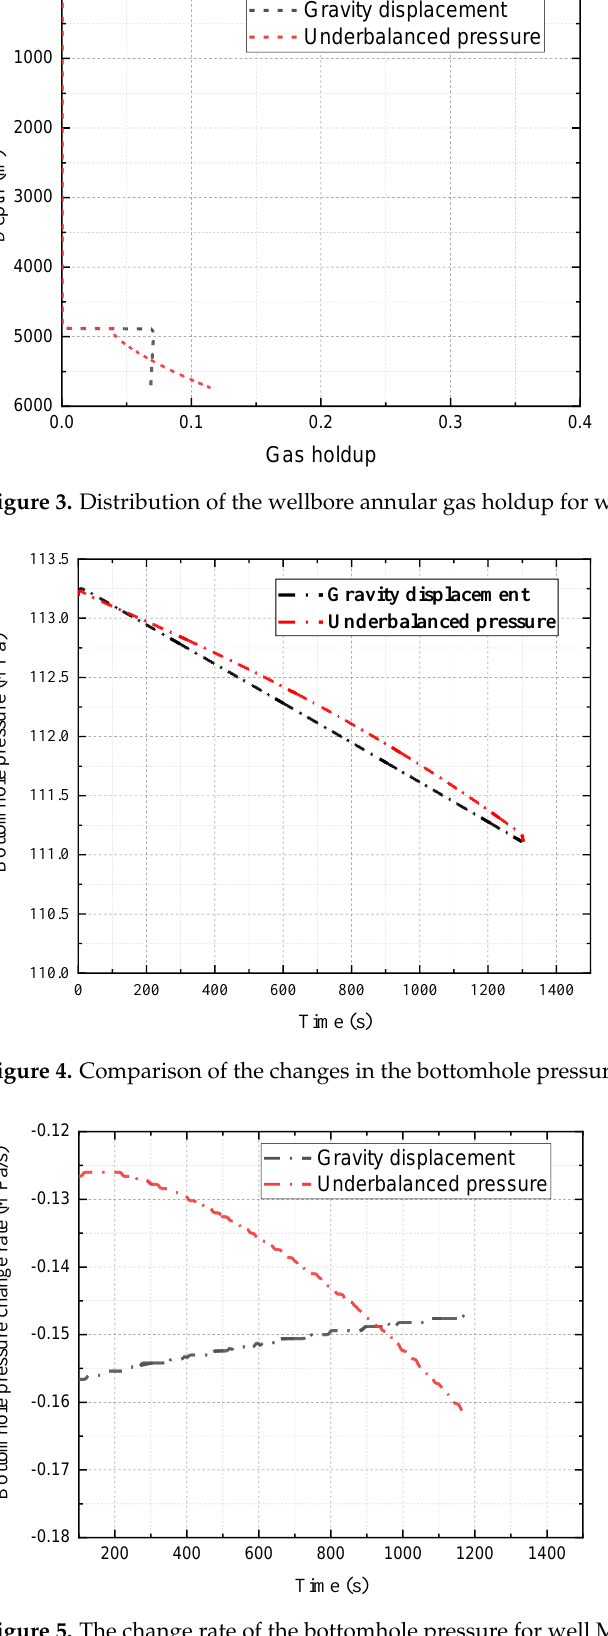
Figure 5. The change rate of the bottomhole pressure for well M. Figure 6 illustrates the variation of the pit gain with time, during the underbalanced pressure gas kick and the gravity displacement gas kick, and their overflow volumes both reach 2 m 3 at 1300 s. It can be seen that the pit gain under the gravity displacement gas kick is approximately a straight line with time, while it presents a curve with time, during the underbalanced pressure gas kick. The change rate of the pit gain with time is the in- crement of the wellhead outlet flow rate, as shown in Figure 7. The outlet flow rate under the gravity displacement gas kick increases abruptly at the beginning and increases slowly thereafter, while the outlet flow rate tends to increase continuously during the underbal- anced pressure gas kick. Therefore, they can be determined, based on the outlet flow rate. Figure 6. Comparison of the variation of the pit gain for well M.